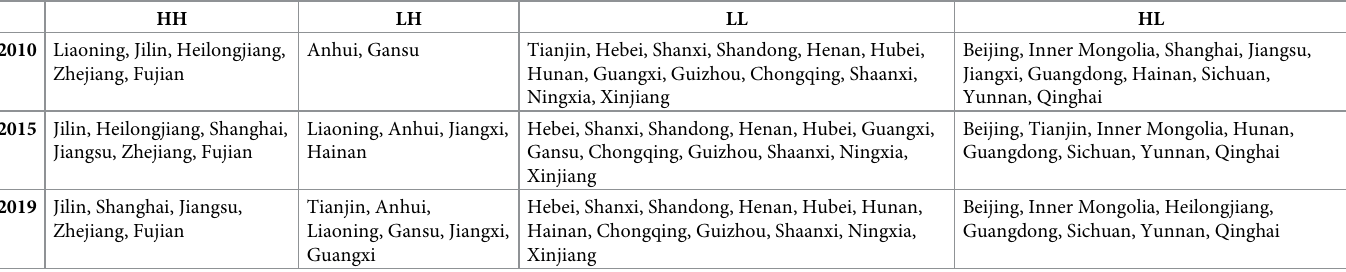
Table 4. Local spatial clustering table of China’s green development level from 2010 to